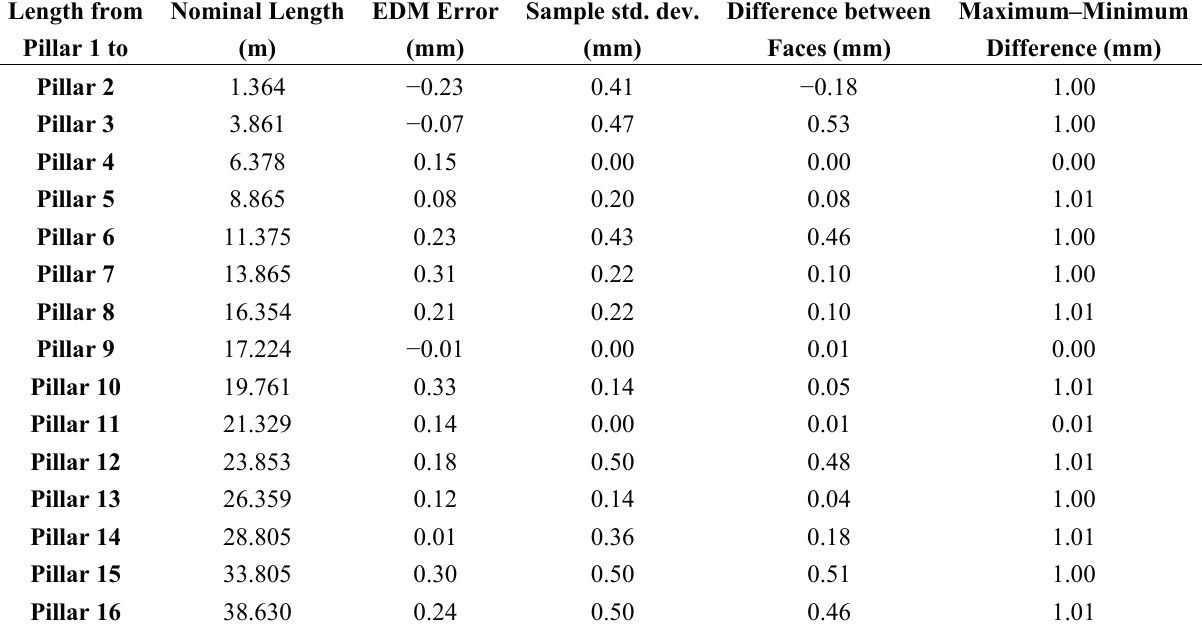
Table 9. Leica TC1800 (25 February 2014).